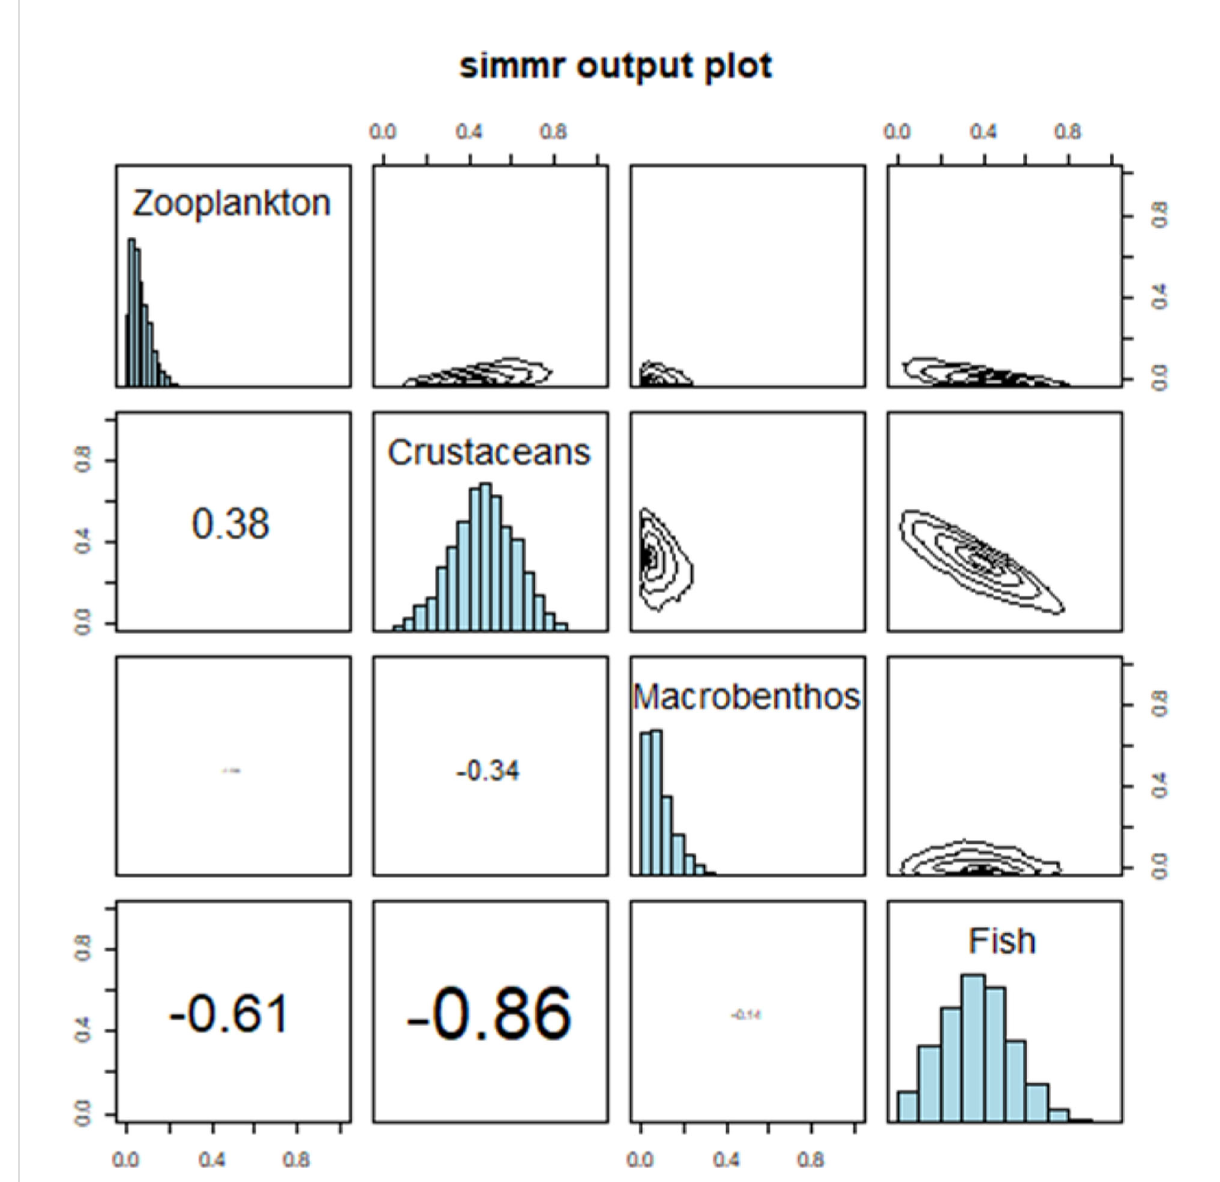
FIGURE 5 Density distribution of the feeding proportion of different food resources of M. senile and the correlation between them (on the right side of the diagonal in the fi gure, contour lines indicate the proportion relationship between different food resources; on the left side of the diagonal, is the correlation coef fi cient between different food resources).